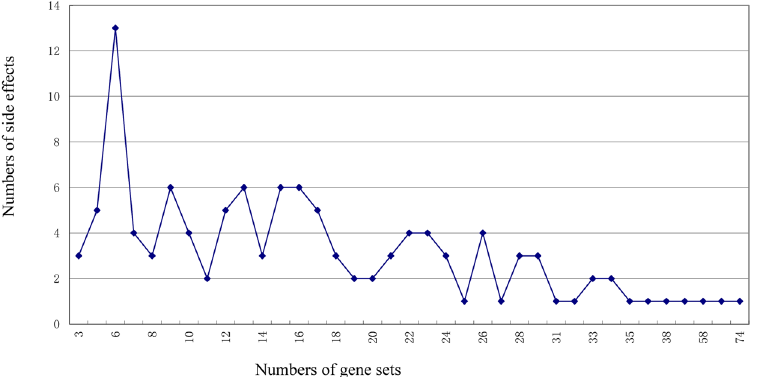
Figure 3. The frequency distribution of side effect regulated by gene sets. The horizontal axis means the number of gene sets which regulated a side effect, and the vertical axis means the number of side effects. The results showed that each side effect was controlled by 17.64 gene sets averagely. Most side effects were related with numerous gene sets, but only three SEs were controlled by three gene sets, and other side effects were associated with at least five gene sets (the largest up to